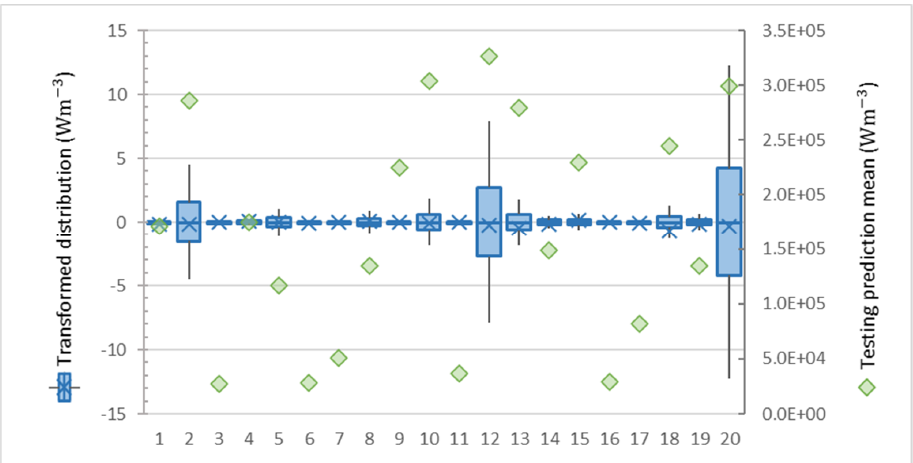
Figure 5. The box plot illustrates the distribution of the transformed prediction for heat source . The scatter plot marks the testing prediction mean for heat source . The predictions for heat source are reliable given that prediction means are in the order of 10 (cid:2873) while the transformed prediction dis- tributions are in the order of 10 (cid:2868) .